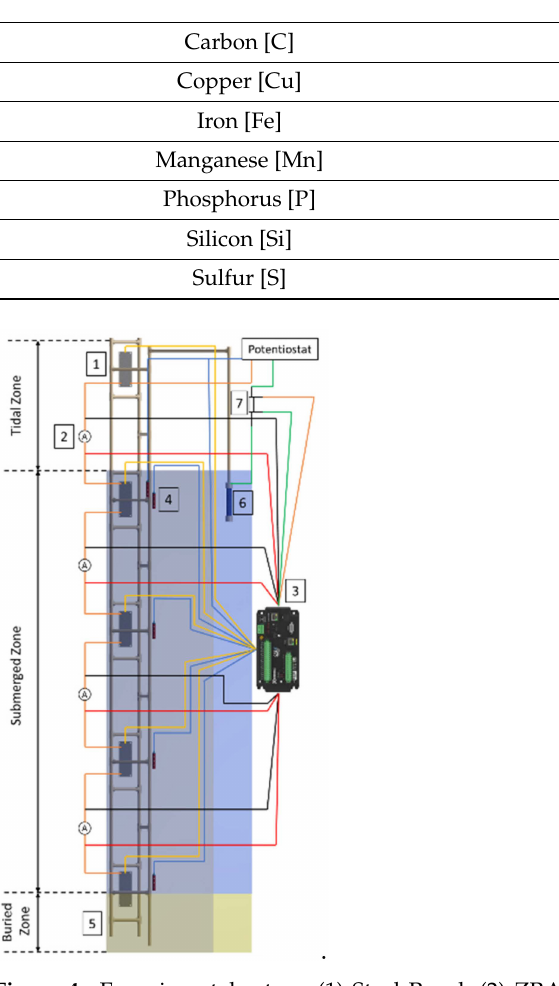
Figure 4. Experimental setup: (1) Steel Panel, (2) ZRA, (3) Datalogger, (4) Ag/AgCl Reference Electrode, (5) PVC Frame, (6) MMO Anode, (7) 1-Ohm